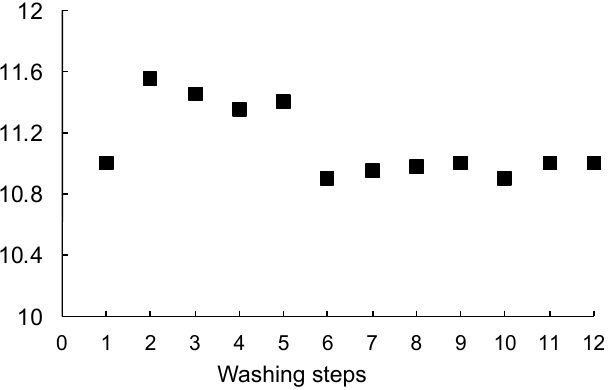
Figure 4. Average pH values as a function of N ws (number of washing steps).